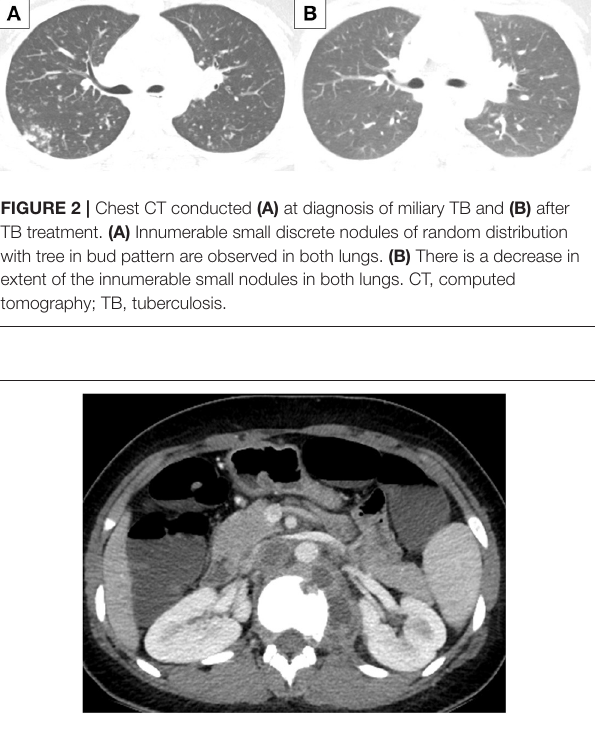
FIGURE 3 | Abdomen CT conducted at 3 months after cessation of miliary TB treatment. A newly defined presumed cold abscess within the left psoas muscle at the level of T10 to L2 and TB spondylitis at the T12 and L1 are observed. CT, computed tomography; TB, tuberculosis.